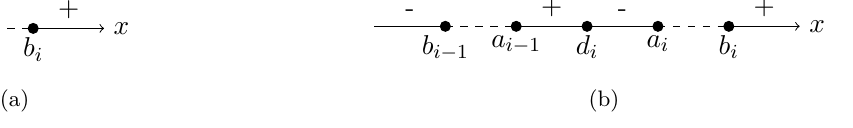
Figure 12 . The left plot shows the sign of C ( x ) in the neighborhood of a positive cut. The right plot shows there must be at least one zero, or generally odd number of zeros, between two cuts to fix the